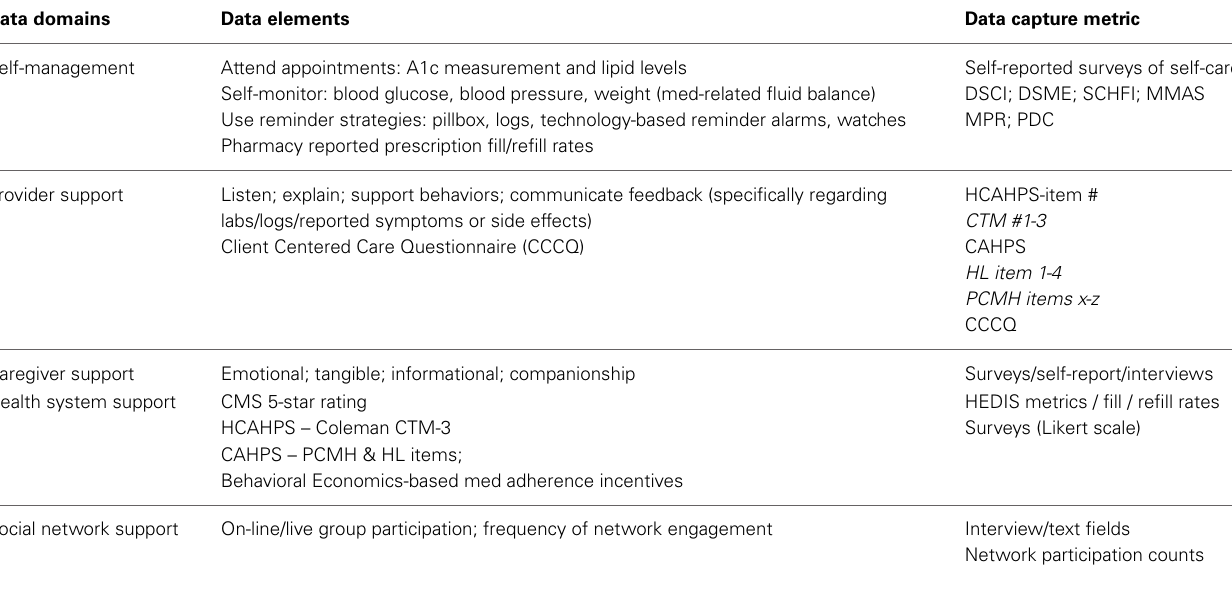
Table 5B | Taxonomy domains and element definitions: management of